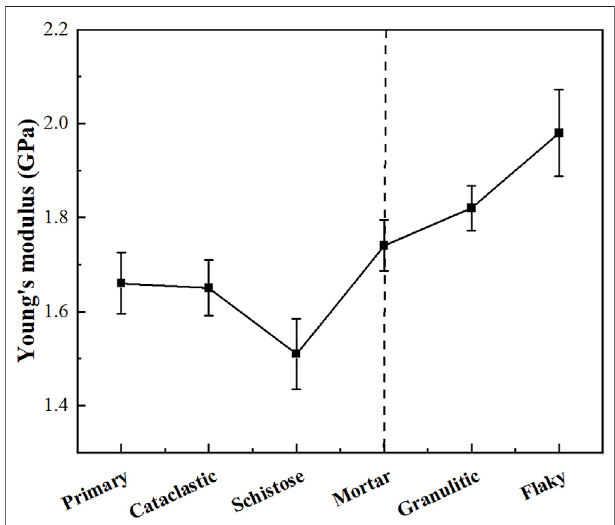
FIGURE 10 | Young ’ s modulus of coal